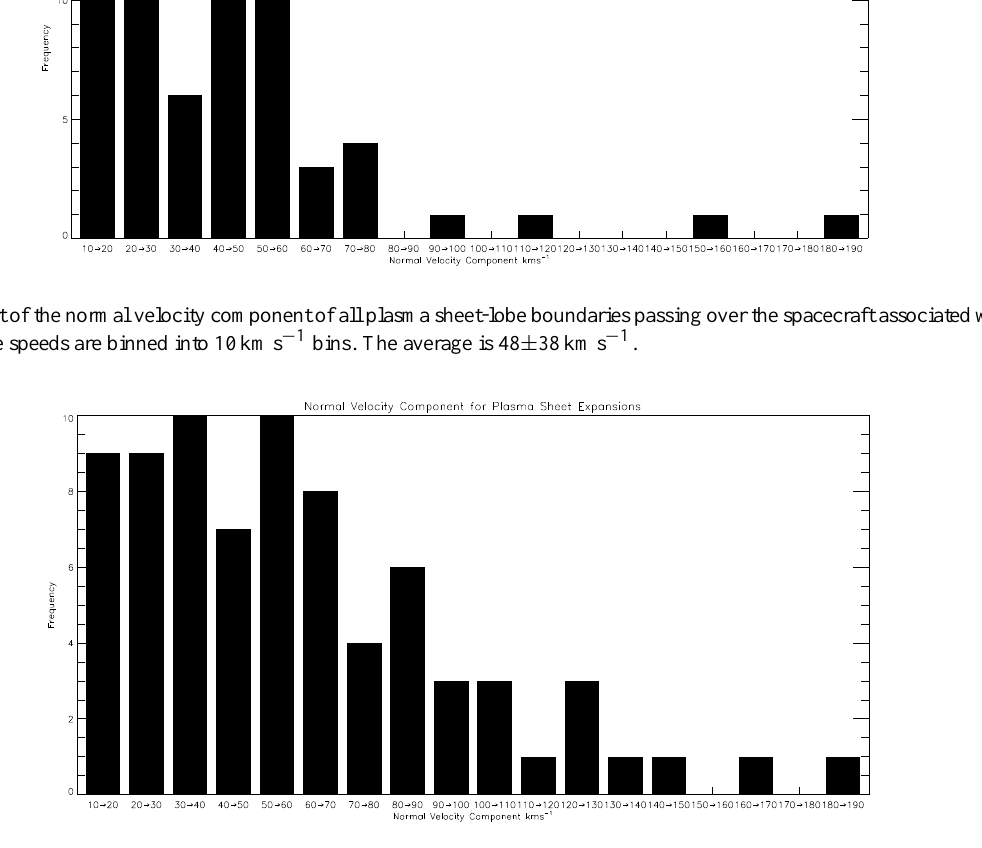
events with a thinning to expansion normal velocity ratio